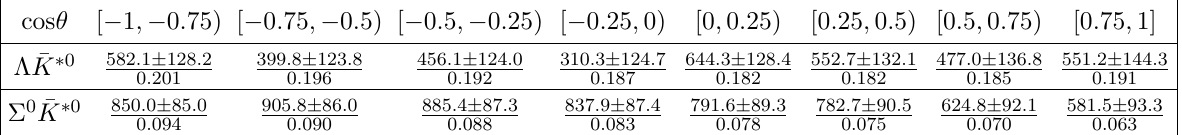
Reconstruction efficiency → Σ 0 ¯ K ∗ 0 . c